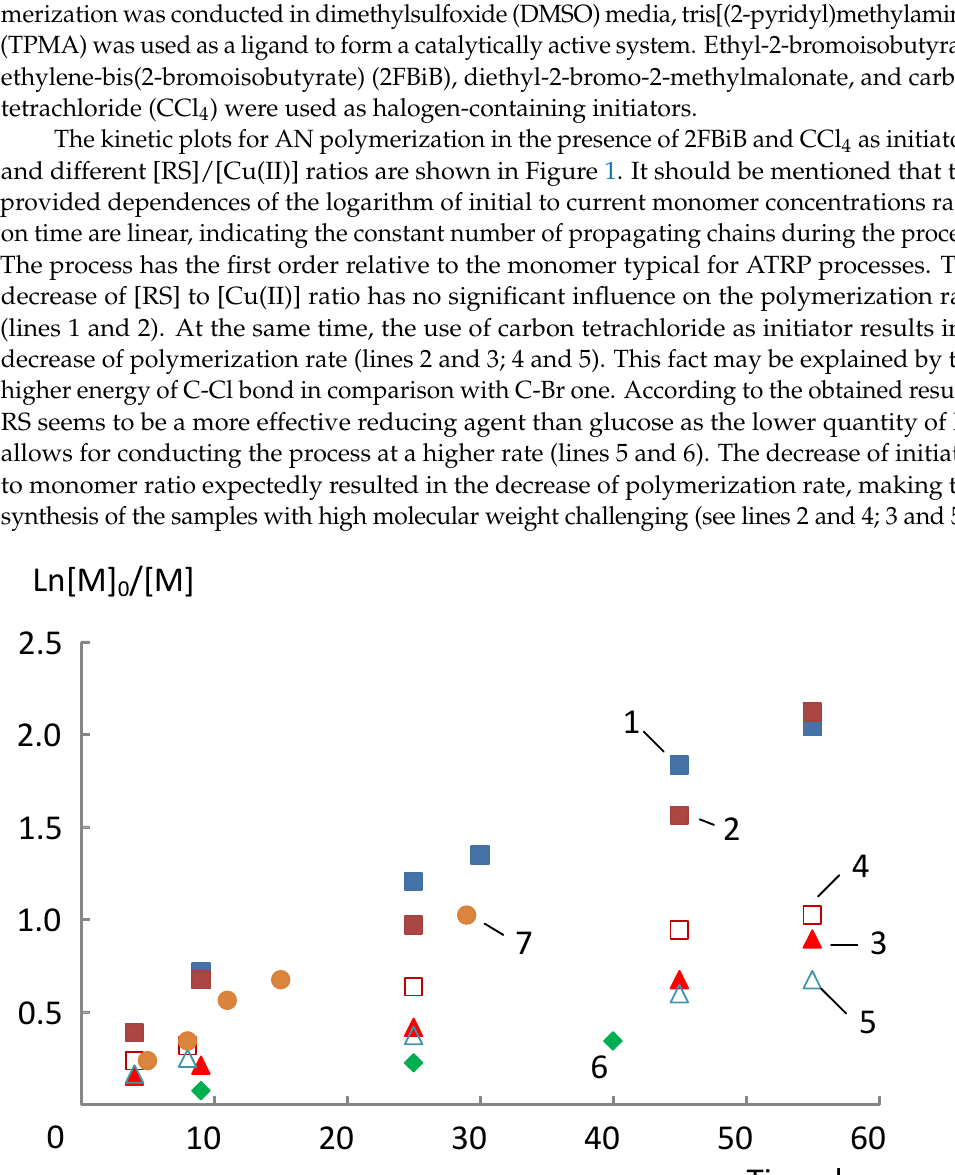
The dependences of molecular weights and dispersity (Ð = M w /M n ) of the samples on conversion are provided in Figure 2. The polymerizations at [I] 0 :[M] 0 = 1:900 ratio proceed with the linear increase of molecular weights of the samples with conversion. A good agreement with theoretically calculated values typical for ATRP processes is observed.